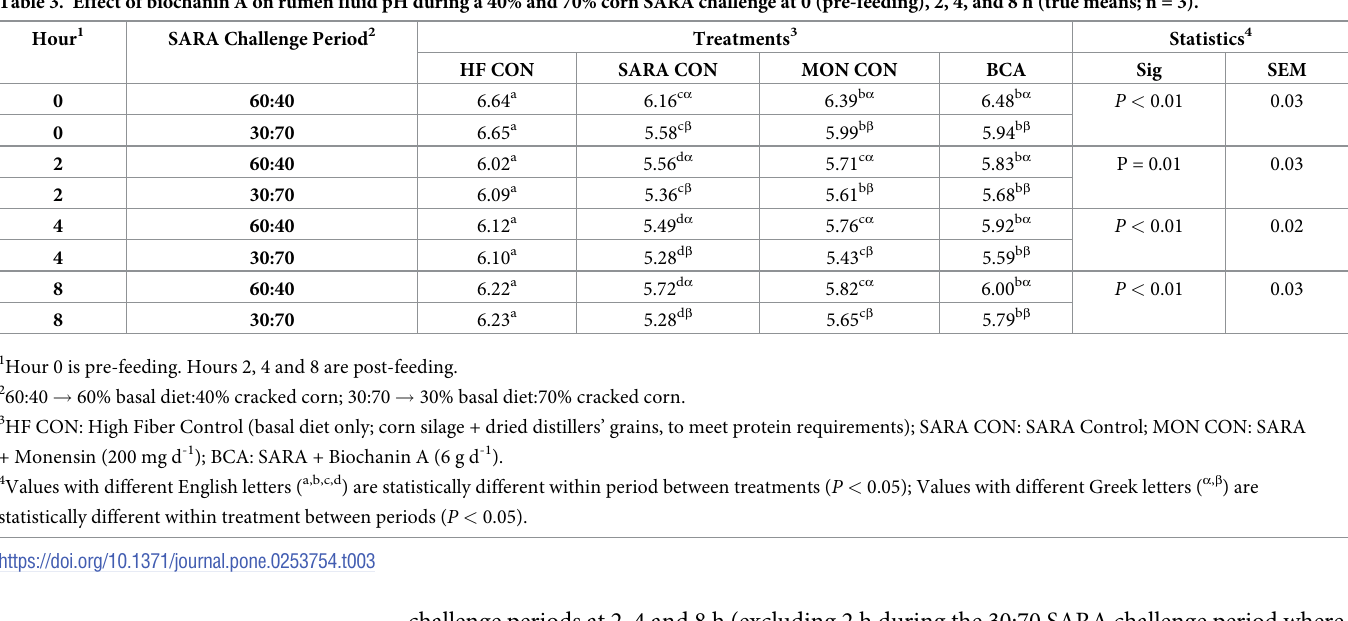
Values with different English letters ( a,b,c,d ) are statistically different within period between treatments ( P < 0.05); Values with different Greek letters ( α , β ) are statistically different within treatment between periods ( P <